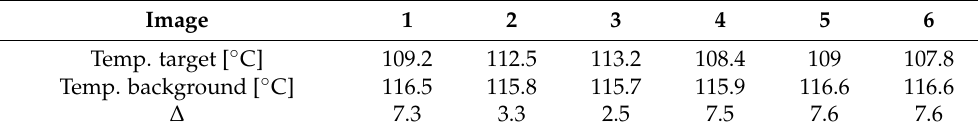
Table 3. Influence of the working temperature of the camera on the accuracy of thermal measurement.